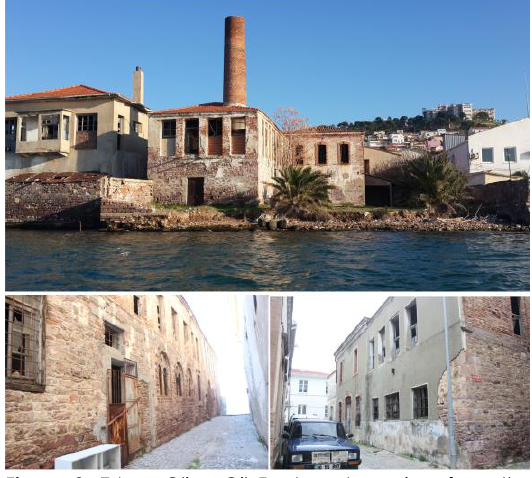
Figure 3 : Ertem Olive Oil Factory, top: view from the sea; bottom left: the most elaborated façade; bottom right: entrance façade (taken by Gözde Yıldız, 2015)